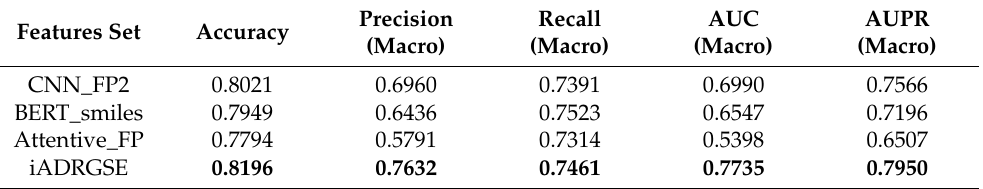
Table 2. Results of the baseline and iADRGSE on independent test sets.